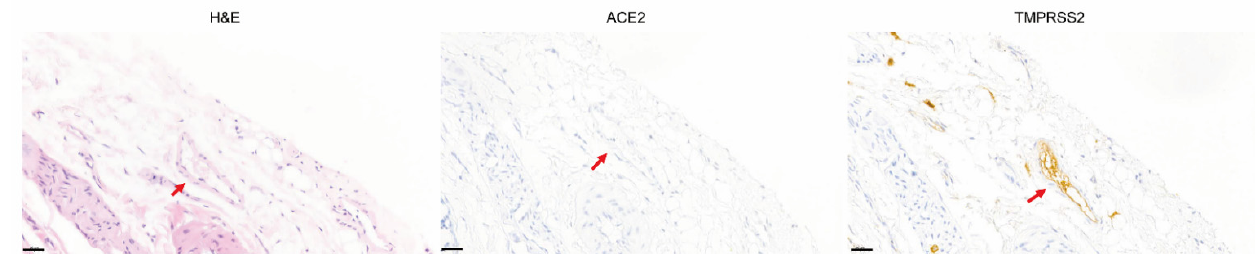
Figure 3. Expression of TMPRSS2 in the rat thyroid. Only TMPRSS2, not ACE2, was stained in relatively large vessels (arteriole/venule) (arrow) outside the rat thyroid gland. Scale bar = 20 µ m. ( H&E ), hematoxylin and eosin; ( ACE2 ), angiotensin-converting enzyme 2; ( TMPRSS2 ), transmem- brane protease